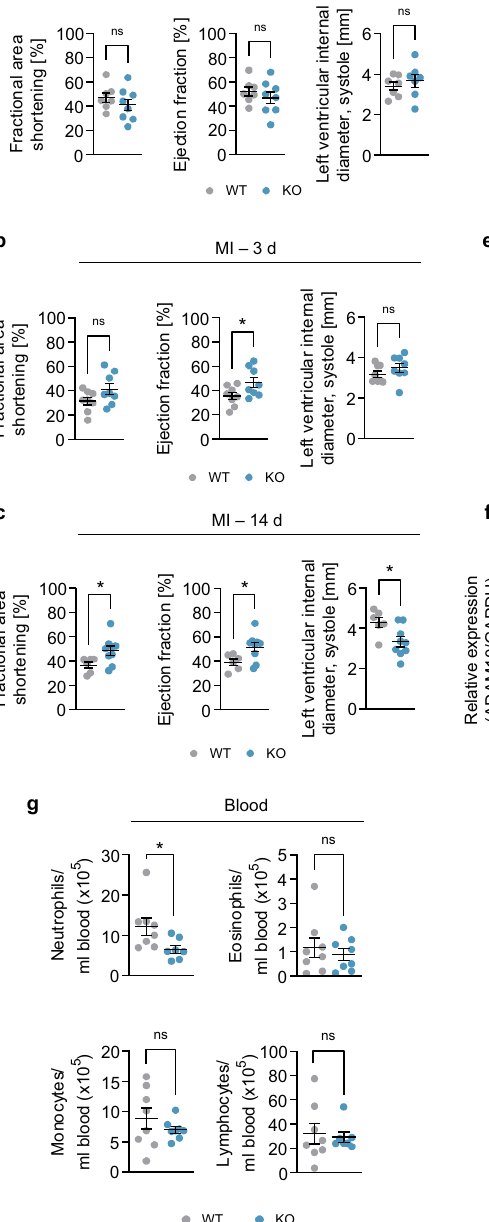
Fig. 6 | Cardiomyocyte-speci fi c ADAM10 KO improves post-MI cardiac func- tion. a – c Echocardiographic assessment of fractional area shortening, ejection fraction and left ventricular end-systolic interior diameter in 8-week-old ADAM10 fl / fl (WT) and ( α MHC-Cre) ADAM10 KO mice under a basal conditions (WT, n =7,KO, n =8,mean±SEM,nsnotsigni fi cant)aswellas b 3days(WT, n =8, KO, n =9,mean±SEM,nsnotsigni fi cant,* P <0.05,two-tailed t test)and c 14days after myocardial infarction (WT, n =6, KO, n =9, mean±SEM, ns not signi fi cant, * P <0.05, two-tailed t test, exact P -values are provided in the Source Data fi le). d Representativeend-systolicB-modeandM-modeechocardiogramsofADAM10 WT and ADAM10 KO mice 14 days after myocardial infarction. e Western blot analysis and f quanti fi cation of ADAM10, CX3CL1 and IL-1 β expression in